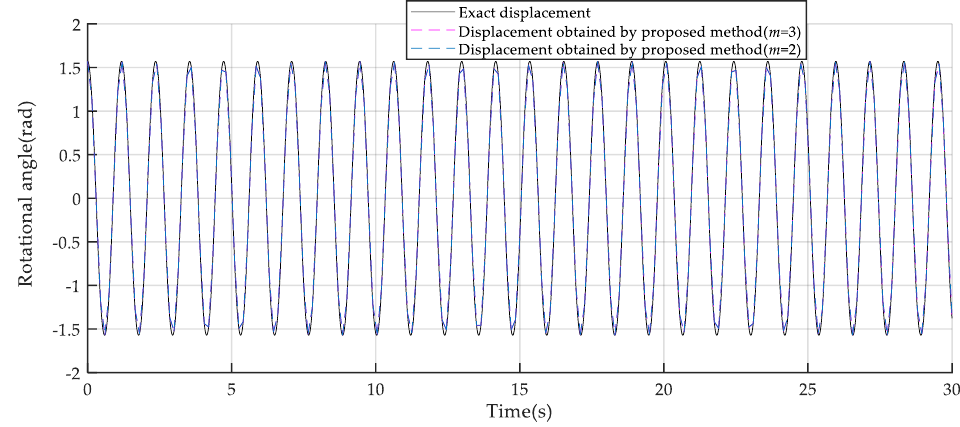
Figure 10. Displacement response of the present method with m = 2,3.